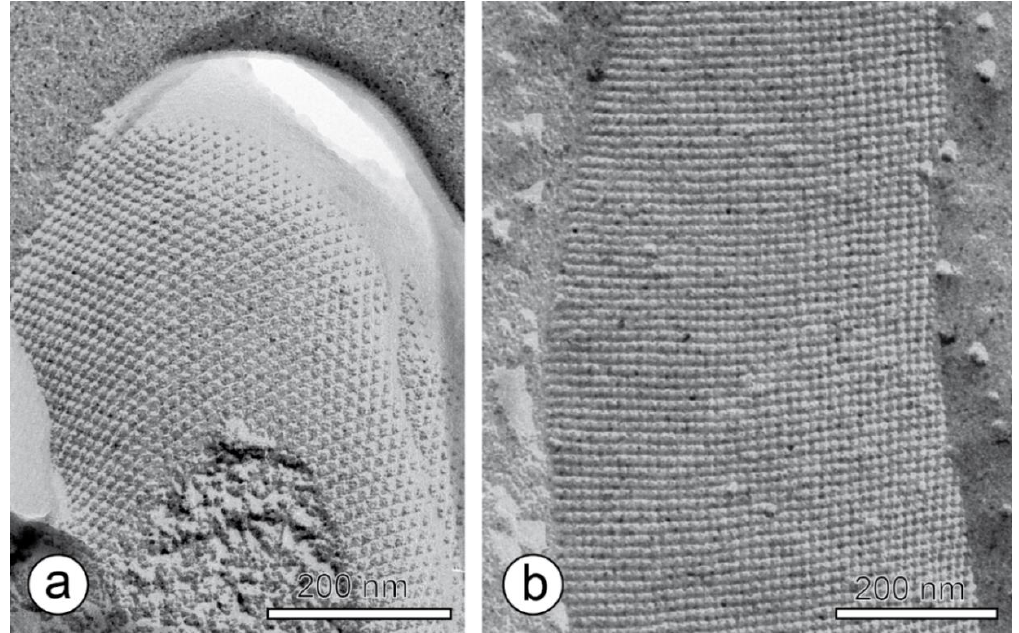
Figure 3. Transmission electron microscopy image of a freeze-etched and metal shadowed preparation of ( a ) an archaeal cell (from Methanocorpusuculum sinense ), and ( b ) a bacterial cell (from Desulfotomaculum nigrificans ). Bars, 200 nm. With permission from Sleytr et al. 2014 [7] (CC BY-NC-ND 3.0).